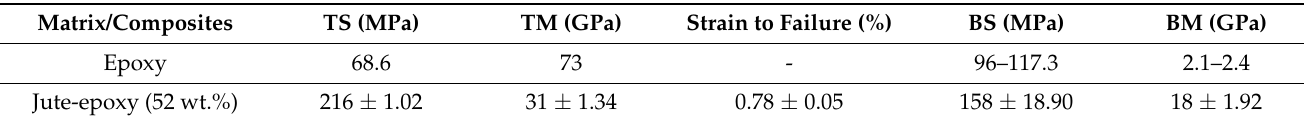
Table 4. Tensile and mechanical properties of jute epoxy composite.